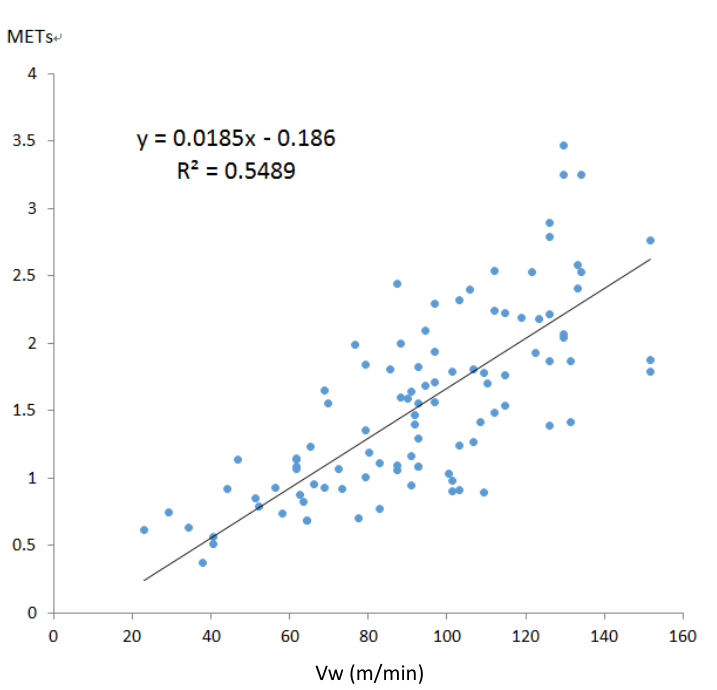
Figure 16. Results of Kurihara’s method reduplicated in this study.